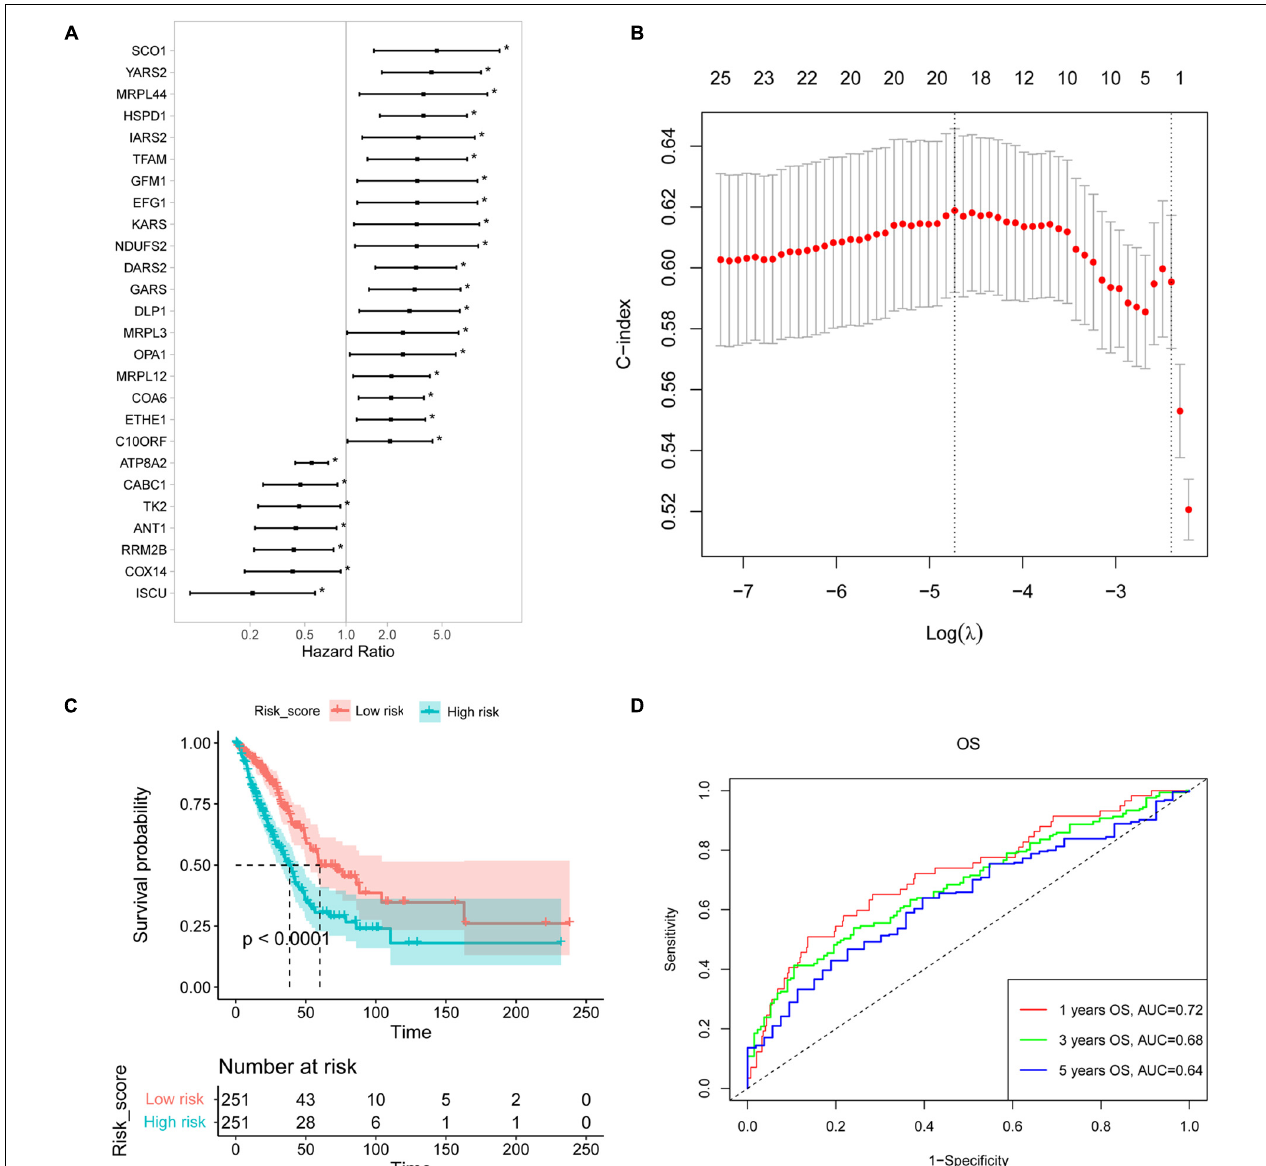
FIGURE 1 | Construction of a survival-related signature based on nuclear mitochondrial genes (NMGs). (A) The forest plot of the associations between the expression levels of 26 genes and overall survival in LUAD patients. Hazard ratios (HR), P -value, and corresponding 95% confidence intervals were calculated by univariate Cox regression analysis. (B) The result of LASSO regression analysis. The vertical dotted lines were drawn at the optimal values by using the maximum and lambda.min criteria. (C) Kaplan-Meier OS curves for patients with high- and low-risk NMGs signature in the TCGA cohort. (D) The ROC curves for 1-, 3-, and 5-year survival of established NMGs signature. OS, overall survival; LASSO, the least absolute shrinkage and selection operator; ROC, receiver operating characteristic. * P < 0 .